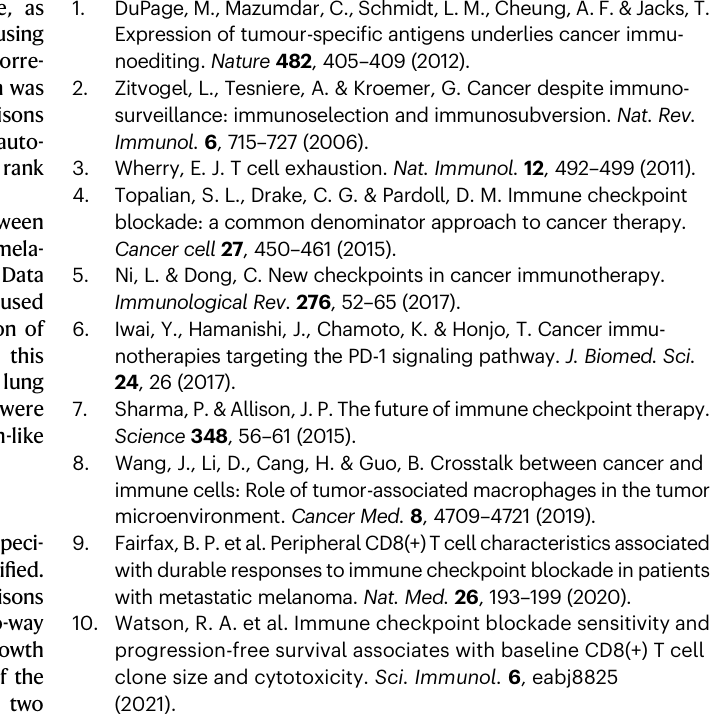
Fig.8|IFN γ RablationinCD8TcellsimprovestumorcontrolinaTcelltransfer model. a – c WT mice bearing B16-OVA were transferred with Control (red), IFN γ RKO (grey) OTI T cells or not transferred (green). a - Mouse survival over time ( n =7 control, n=17 WT and n=18 IFN γ RKO). Data is from 3 independent experi- ments. Mantel-Cox test. b - Tumor volume of individual mice over time ( n =15). Black square highlight tumors with a volume of at least 300mm 3 . Data is from